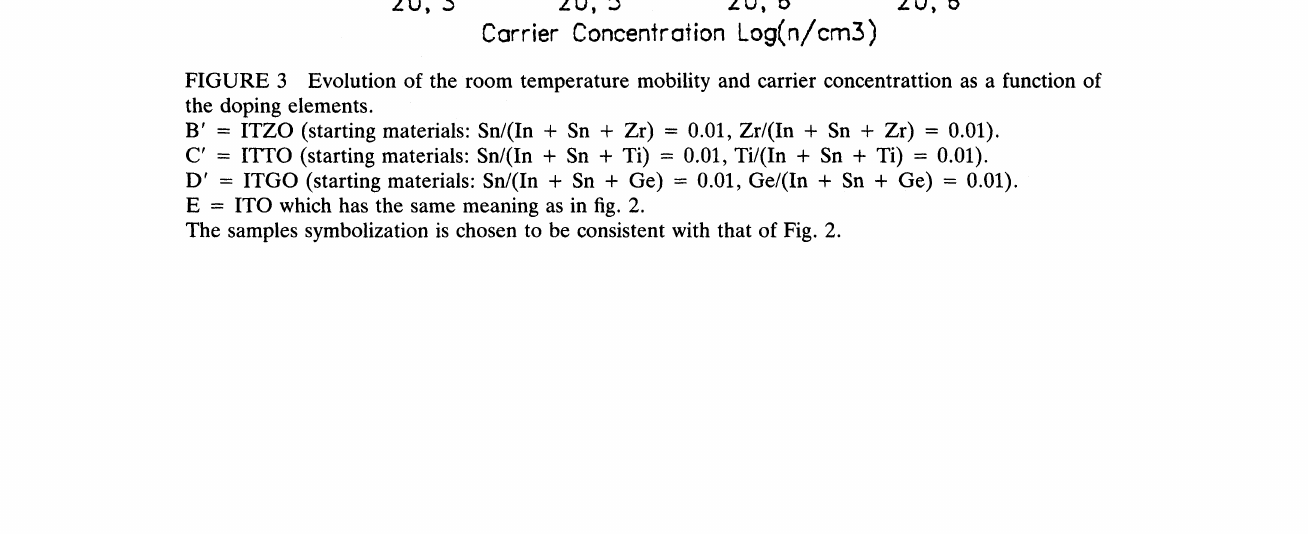
FIGURE 3 Evolution of the room temperature mobility and carrier concentrattion as a function of the doping elements. B’= ITZO (starting materials: Sn/(In + Sn + Zr) 0.01, Zr/(In + Sn +